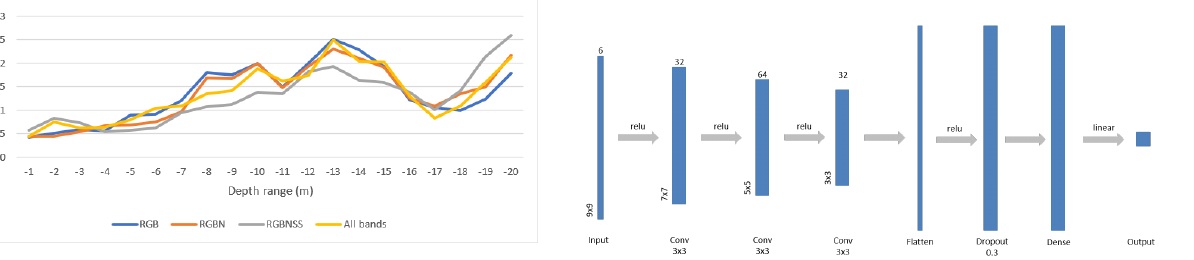
Figure 8. CNN accuracy metric on different number of channels per depth range 1 m.